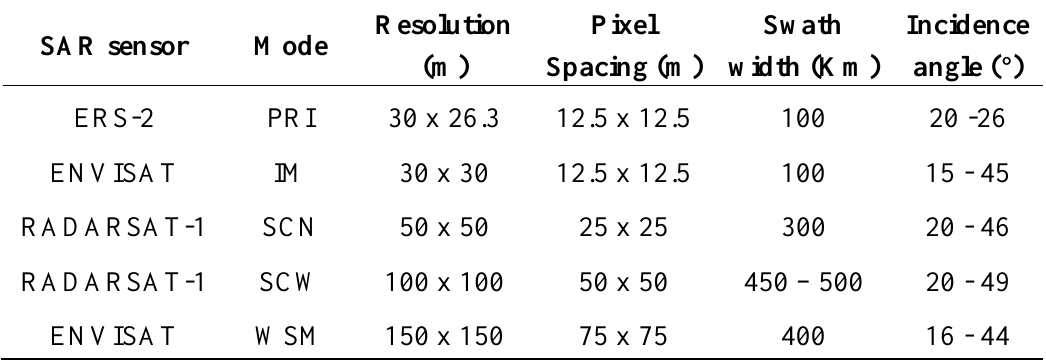
Table 2. Examples of satellite modes (adapted from Brekke and Solberg